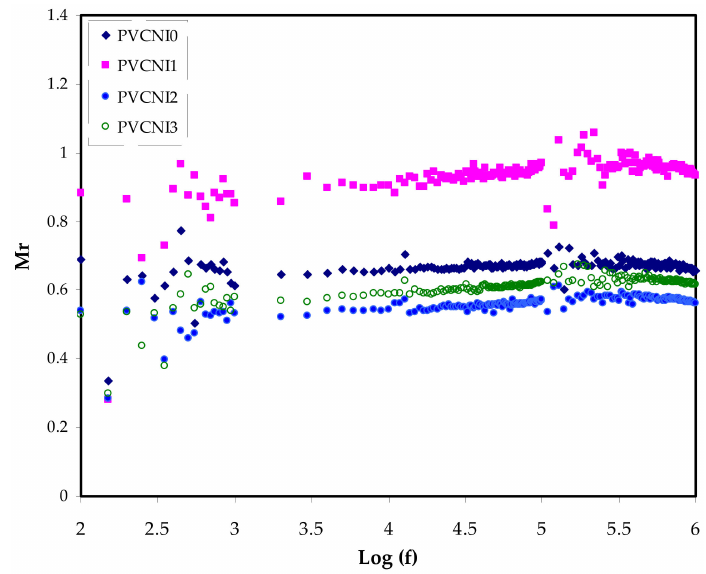
Figure 8. M r versus log ( f ) for all the electrolyte